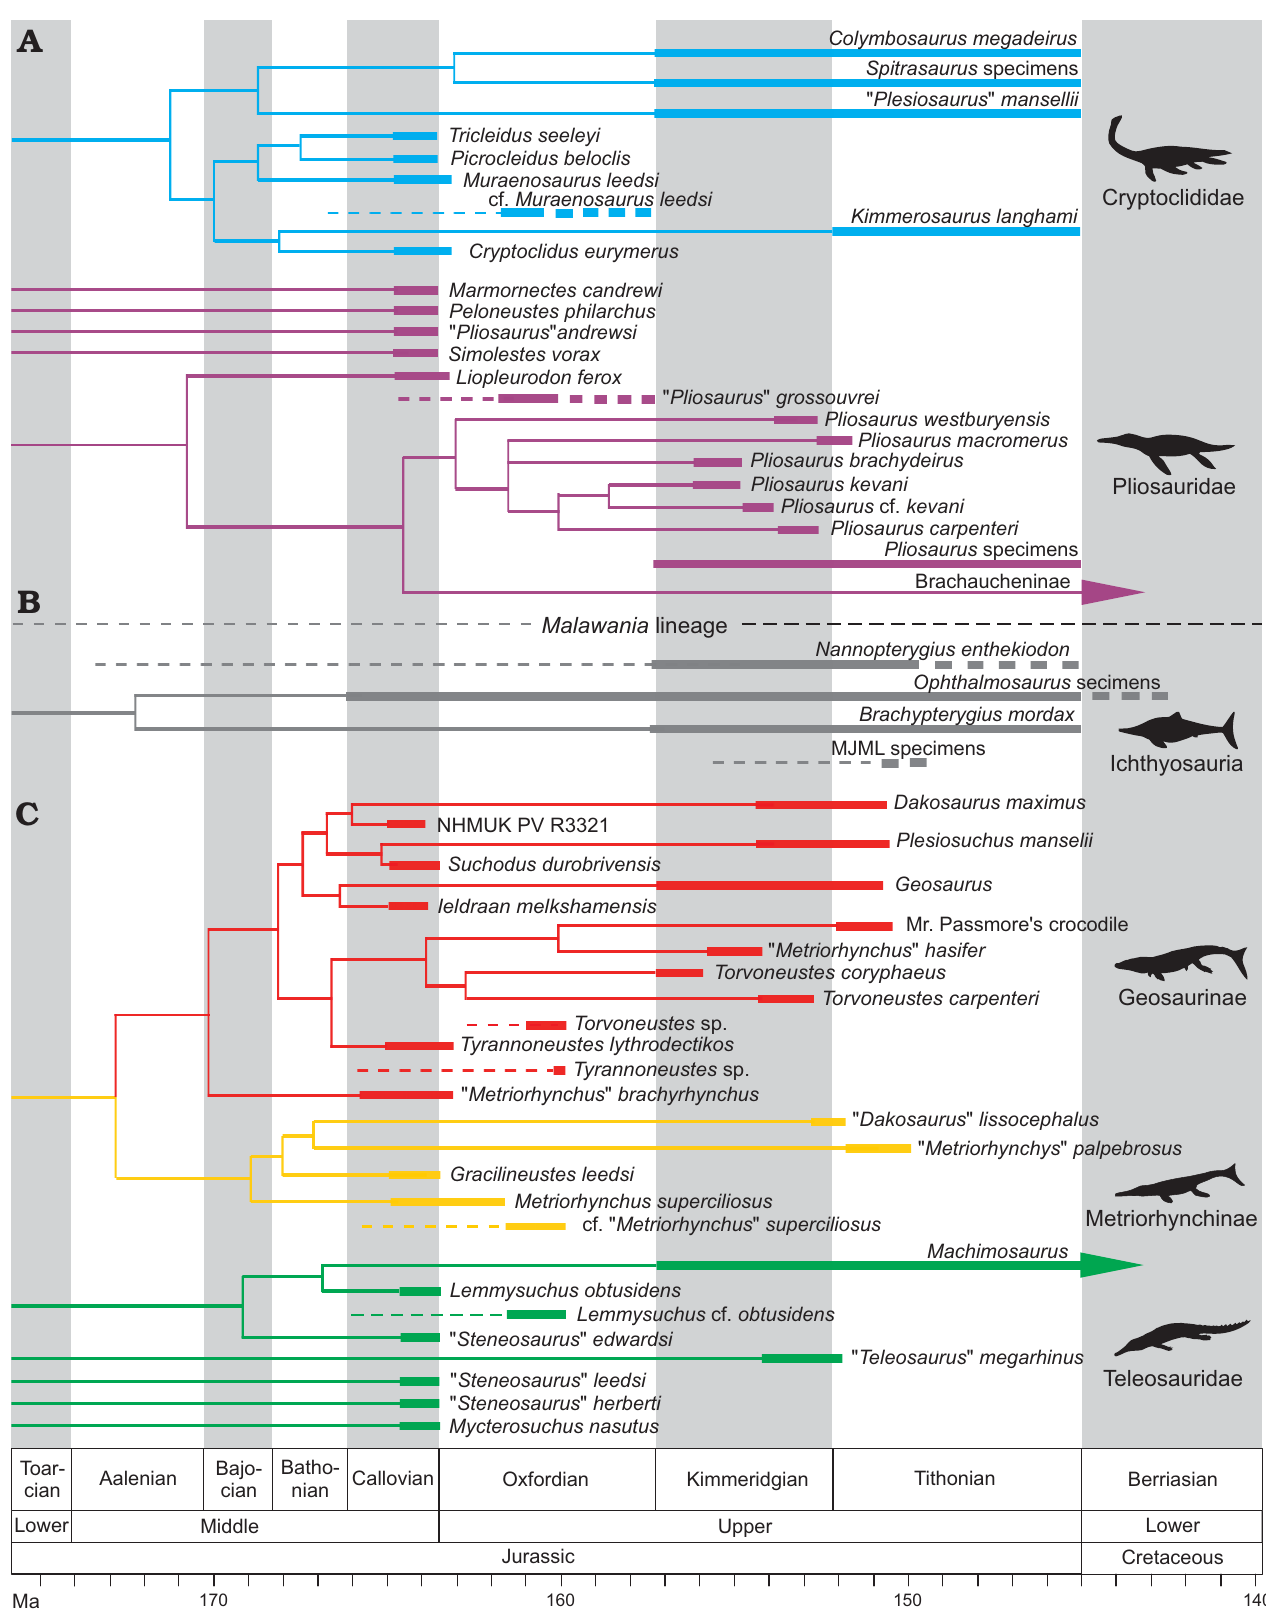
Fig. 14. Time calibrated phylogenetic tree of the main Jurassic Sub-Boreal Seaway marine reptile lineages stratigraphic ranges. A . Plesiosauria (modified from Fischer et al. 2015, 2017). B . Ichthyosauria (modified from Fischer et al. 2014). C . Thalatto suchia (Young et al. 2016; Foffa et al. 2017). MJML, Museum of Jurassic Marine Life—the Steve Etches Collection, Kimmeridge,